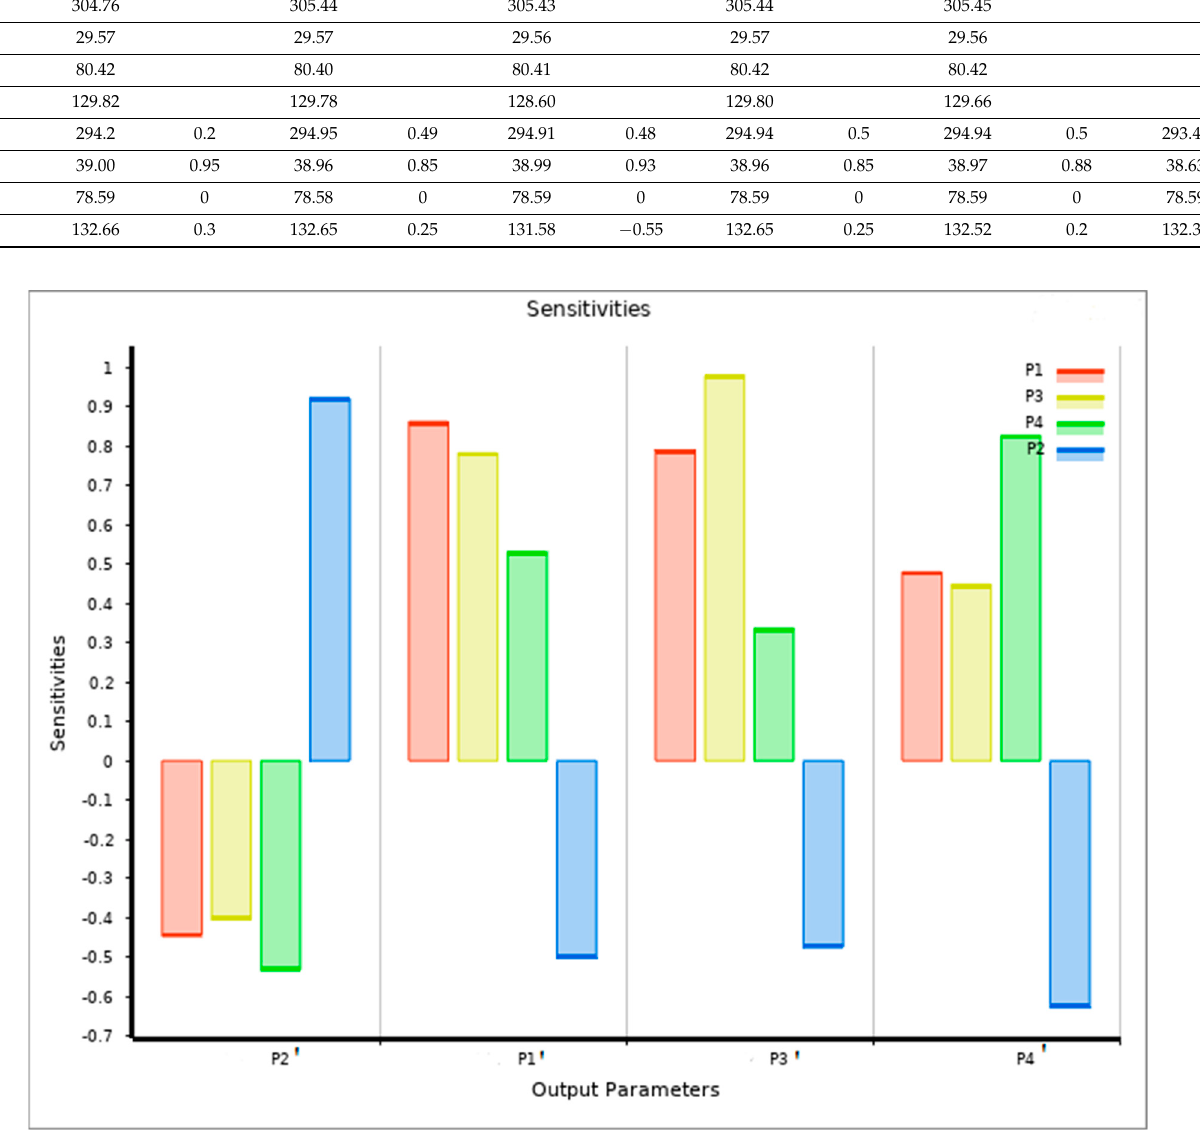
Figure 10. Sensitivity chart of selected parameters showing the sensitivity and inter ‐ dependency levels of the four output parameters (Figure 3b).